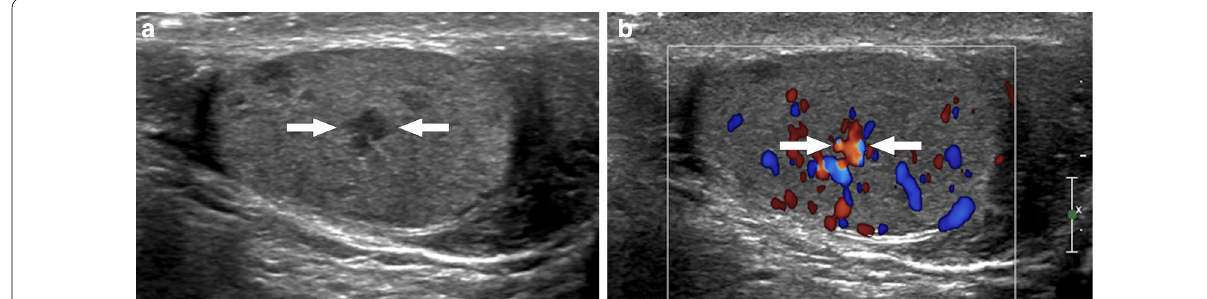
Fig. 17 Leydig’s cell hyperplasia. A 34-year-old male presenting with infertility underwent testicular US exam for primary evaluation. a Gray-scale US image shows several hypoechoic lesions scattered throughout the parenchyma in both testes. The largest lesion was in the right testis (arrows). Both testes were deemed to be small in size when patient’s age was considered. b Color Doppler US image demonstrates intense vascularity within the largest lesion. Provisional diagnosis of Leydig’s cell hyperplasia was made. Genetic analysis confirmed Klinefelter’s syndrome